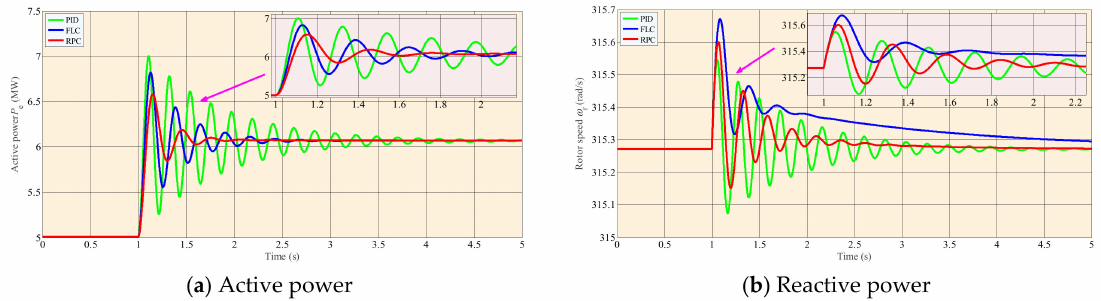
Figure 4. System responses obtained under a pitch angle variation from 15 to 5 deg. in 1 s with a constant wind speed of 12 m/s. ( a ) active power; ( b ) rotor